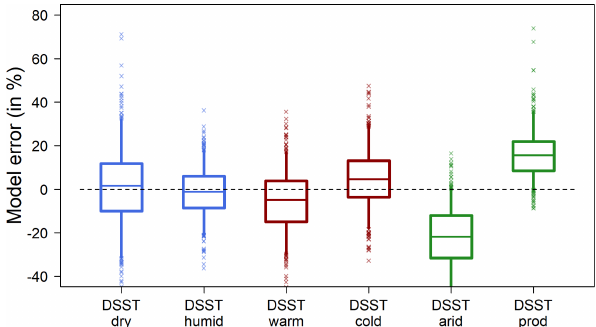
Figure A1. Distribution of model biases in DSST for each type of setup. The box plots represent the 5, 25, 50, 75 and 95 quantiles, and the little crosses denote the outliers. Blue, red and green box plots are, respectively, associated to DSST setups based on precipitation, temperature and runoff